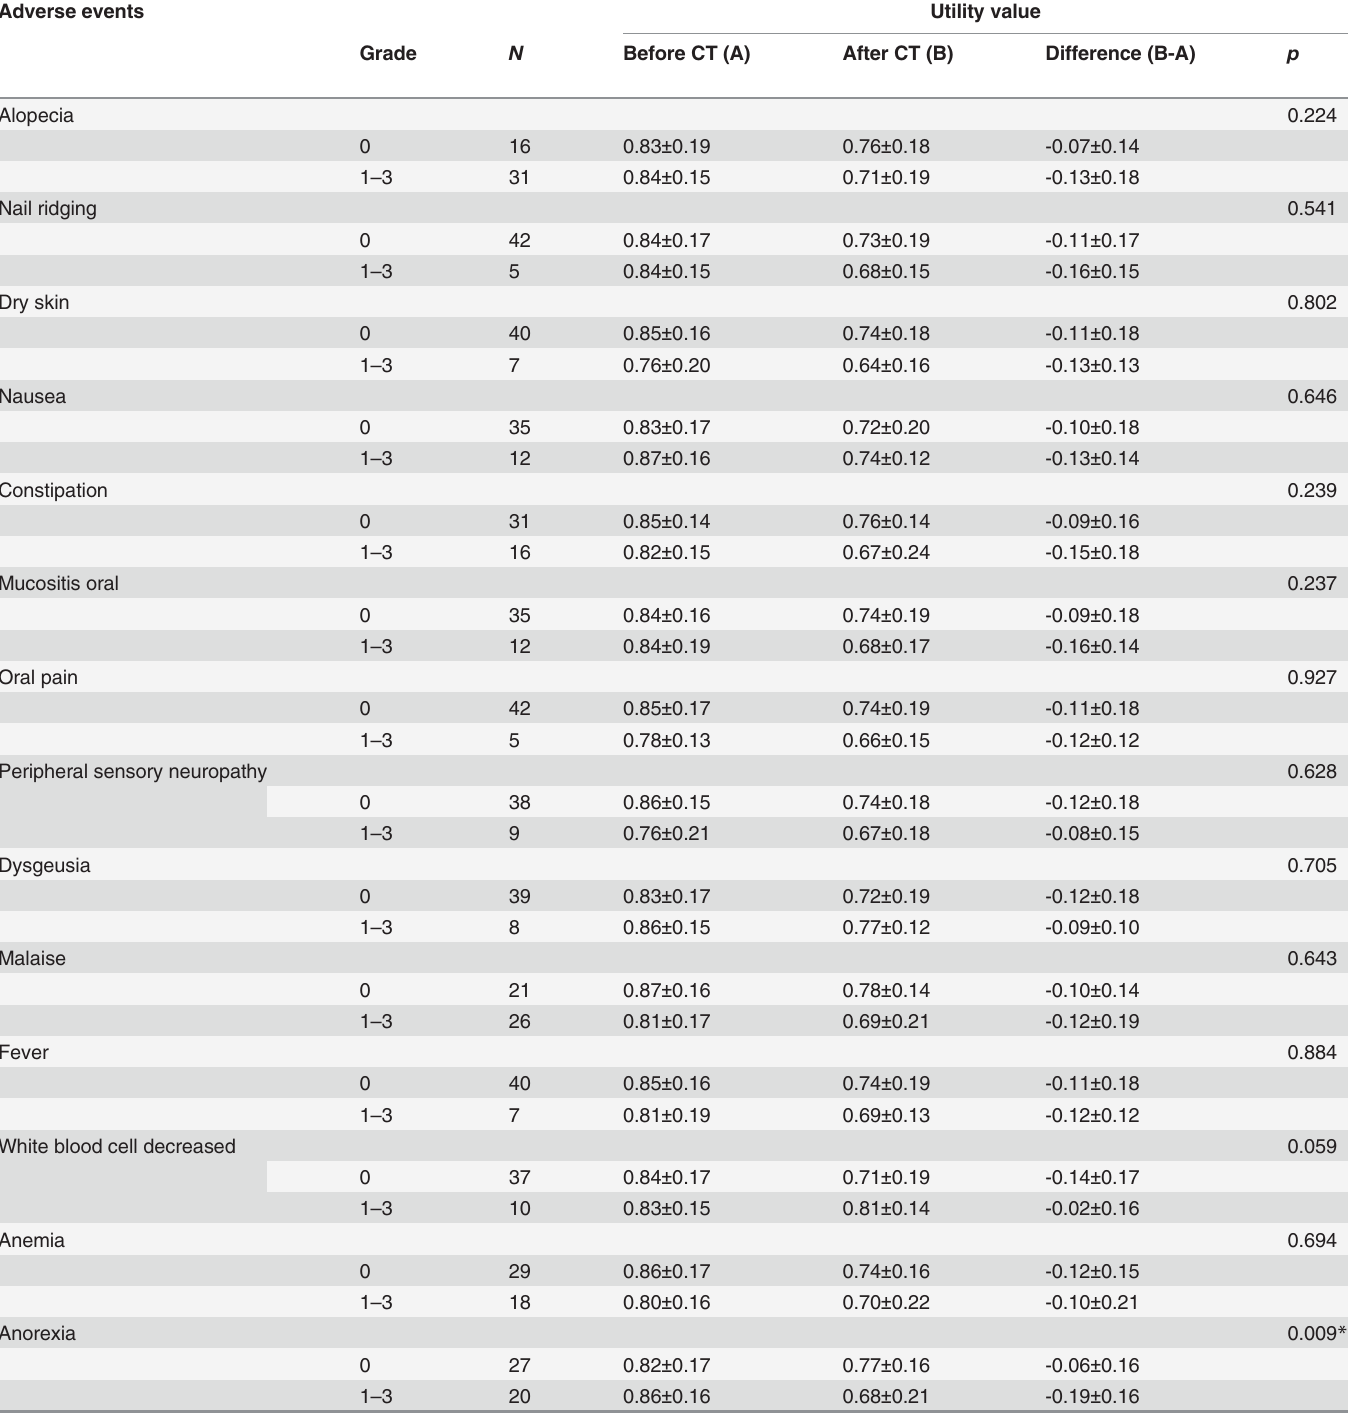
Table 5. Comparison of the EQ-5D utility value according to the presence or absence of individual adverse